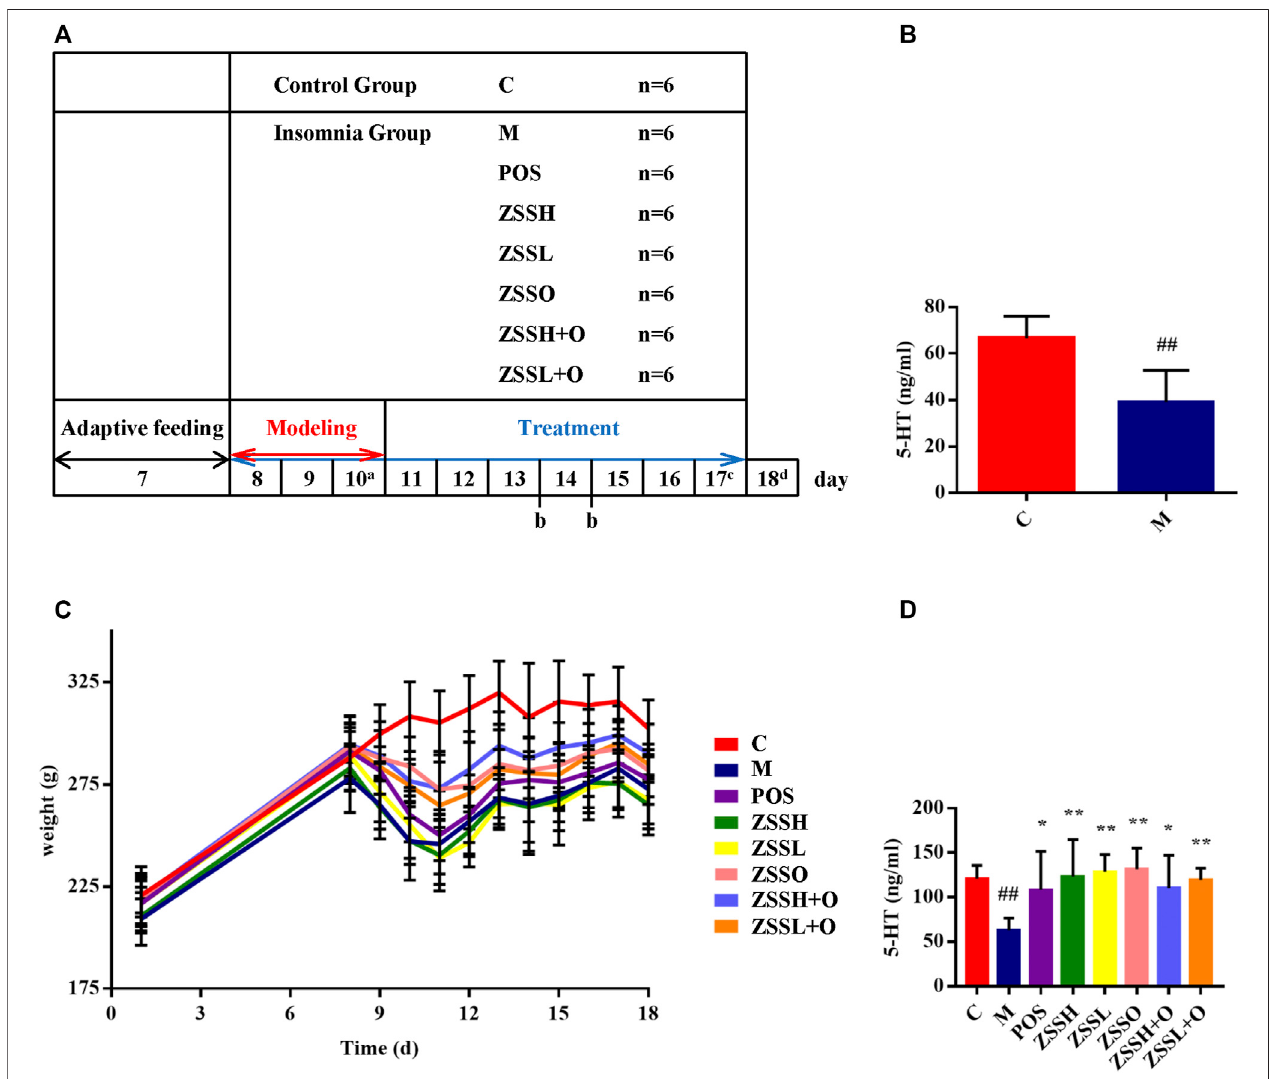
FIGURE1| Aschematicdiagramforthetimedesignofexperiment (A) .a:CollectingCandMgroupplasmaformodelveri fi cation;b:Fastingfor12 handcollecting 12 h urine; c: Collecting fresh feces for 16S rRNA gene sequencing; d: Fasting for 12 h and collecting plasma. Determination of 5-HT among the C and M groups after modeling (B) . Weight changes during the experiment (C) . Determination of 5-HT after experiment (D) . (C) control group; (M) model group; (POS) positive group; (ZSSH) high-dose ZSS ethanol extract group; (ZSSL) low-dose ZSS ethanol extract group; (ZSSO) ZSS oil extract group; (ZSSH + O) high-dose ZSS ethanol + oil extract group; (ZSSL + O) low-dose ZSS ethanol + oil extract group. Values are presented as the mean ± SD, n (cid:2) 6. # p < 0.05, ## p < 0.01: model vs control; * p < 0.05, ** p < 0.01: treatment vs model.